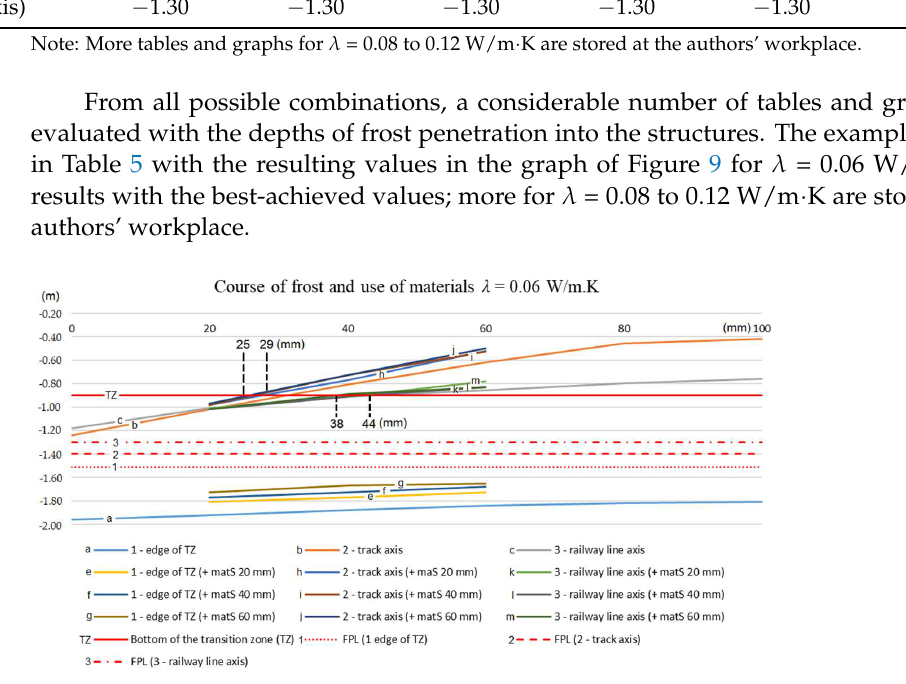
Figure 9. The course of frost and use of materials, λ = 0.06 W/m·K.